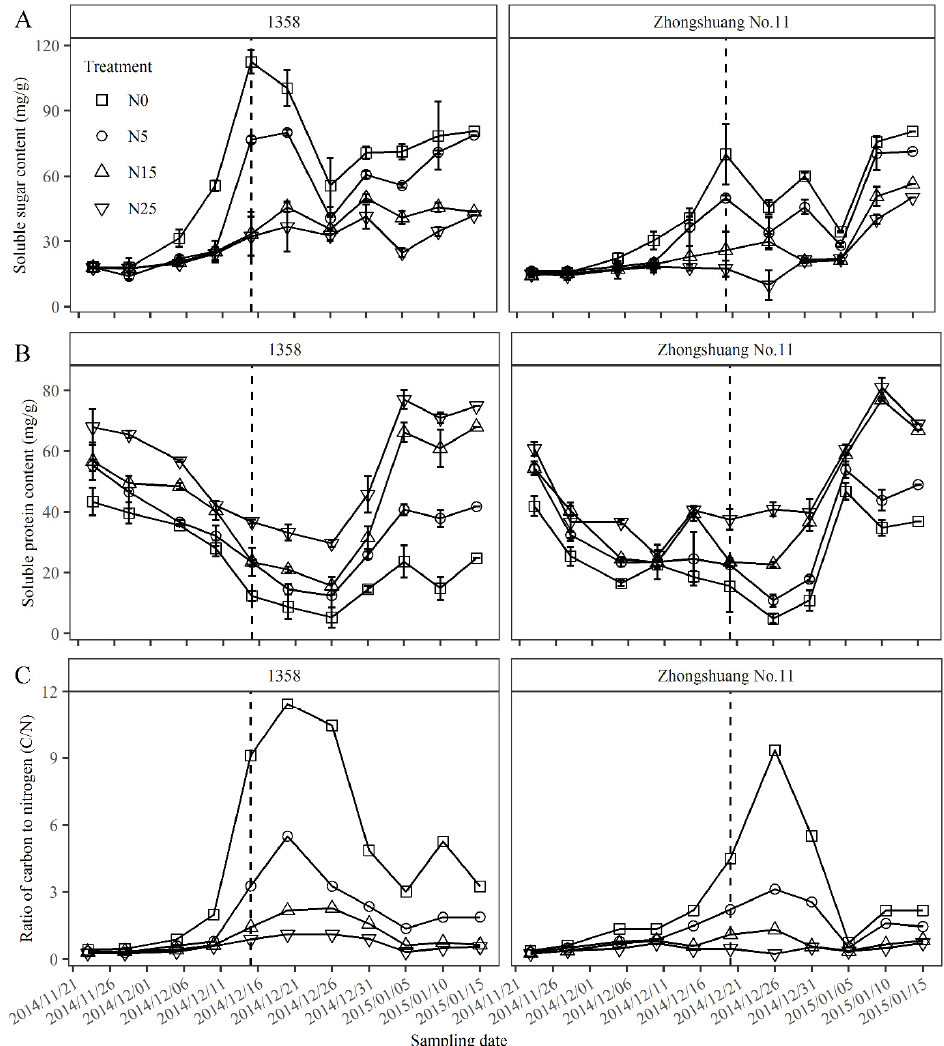
Figure 3. The dynamic changes of soluble sugar ( A ), soluble protein ( B ), and carbon–nitrogen ratio ( C ) of spring rapeseed variety “1358” and semi-winter variety “Zhongshuang No. 11” under prior- and post- floral initiation stages. The dates indicated by the dotted line on the x -axis correspond to floral initiation’s start dates, which was 15 December and 20 December for spring and semi-winter ecotypes, respectively. N0, N5, N15, and N20 represent the nitrogen application rates at 0 kg ha − 1 , 75 kg ha − 1 , 225 kg ha − 1 , and 375 kg ha − 1 , respectively.